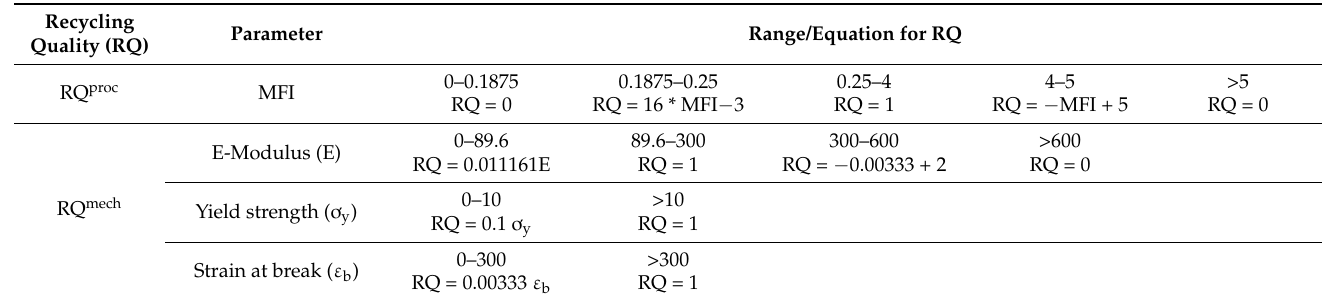
Table 5. Calculation method for evaluating the quality of the recyclates, adapted from